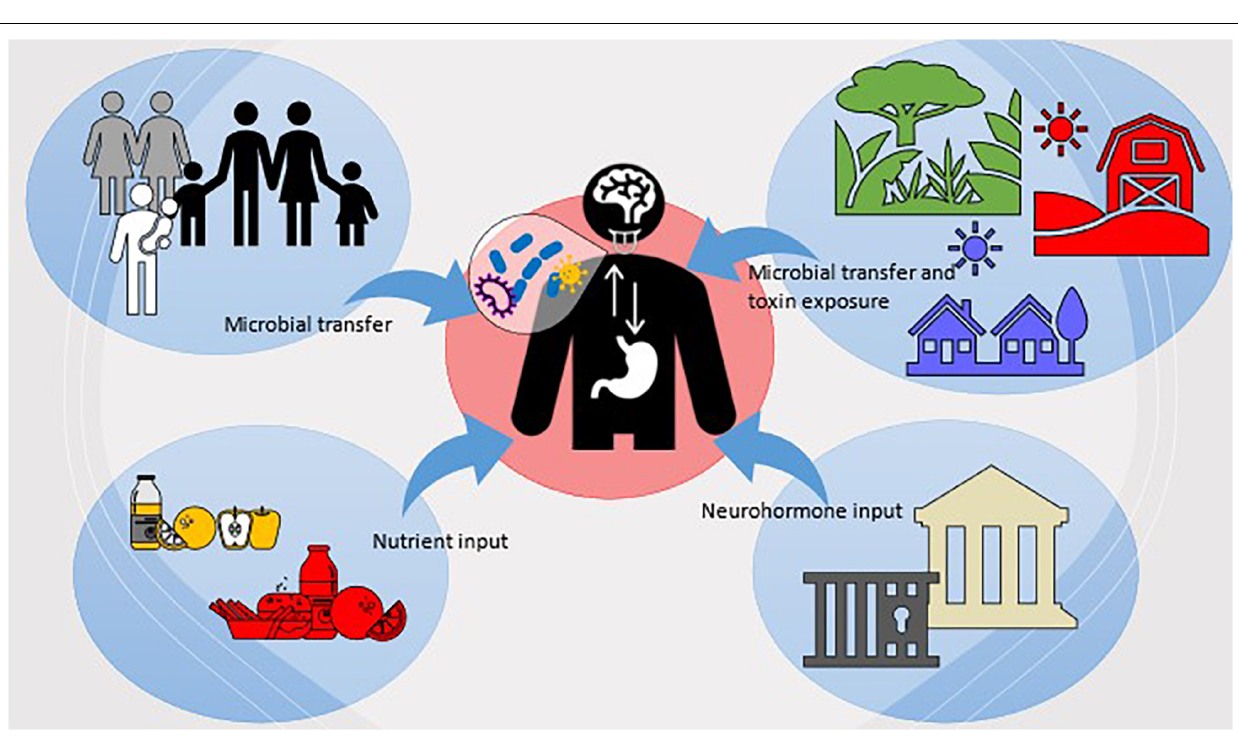
FIGURE 2 | Visualization of the sociocultural and environmental factors which influence host microbiota and the